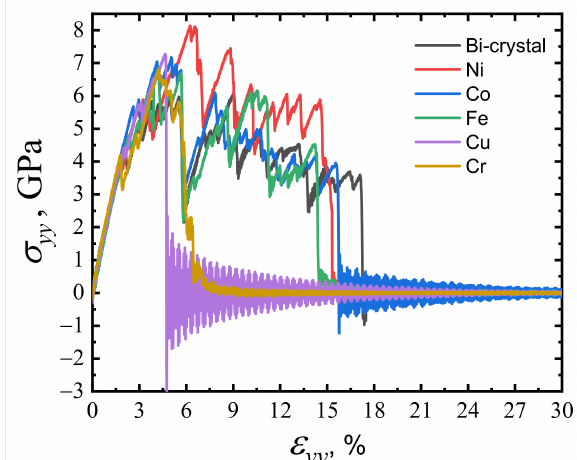
Figure 8. The tensile stress–strain curves for the considered bicrystals. The corresponding type of segregated element is indicated in the legend for each bicrystal, while the case without GB segregation is denoted as Bicrystal. The stress drop to zero corresponds to a break in the bicrystal. The considered temperature is 100 K. The thickness of the segregated layer is 5